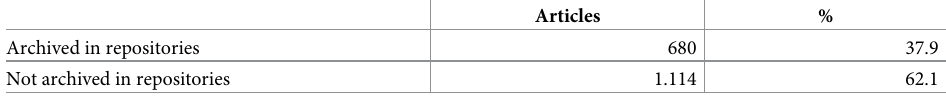
Table 14. Availability of articles resulting from state projects in repositories (2013–2015).